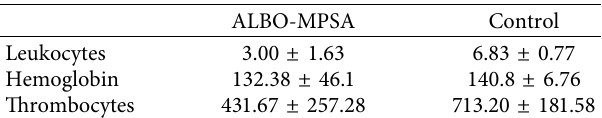
Figure 1: Average body weights of experimental and control animals during the study of subchronic systemic toxicity of the dental material ALBO-MPSA. Table 1: Results of blood analysis.